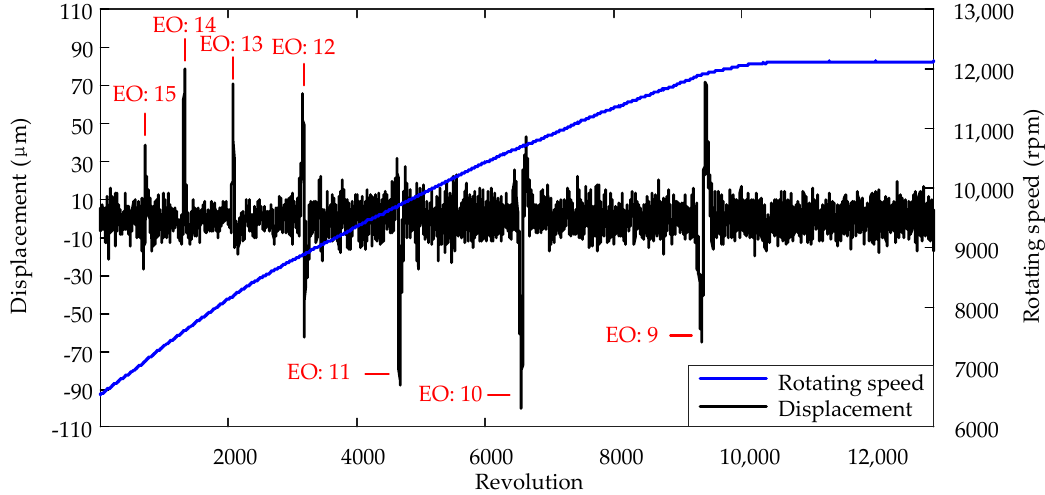
Figure 12. The displacement of blade 7 measured by probe P 0 .